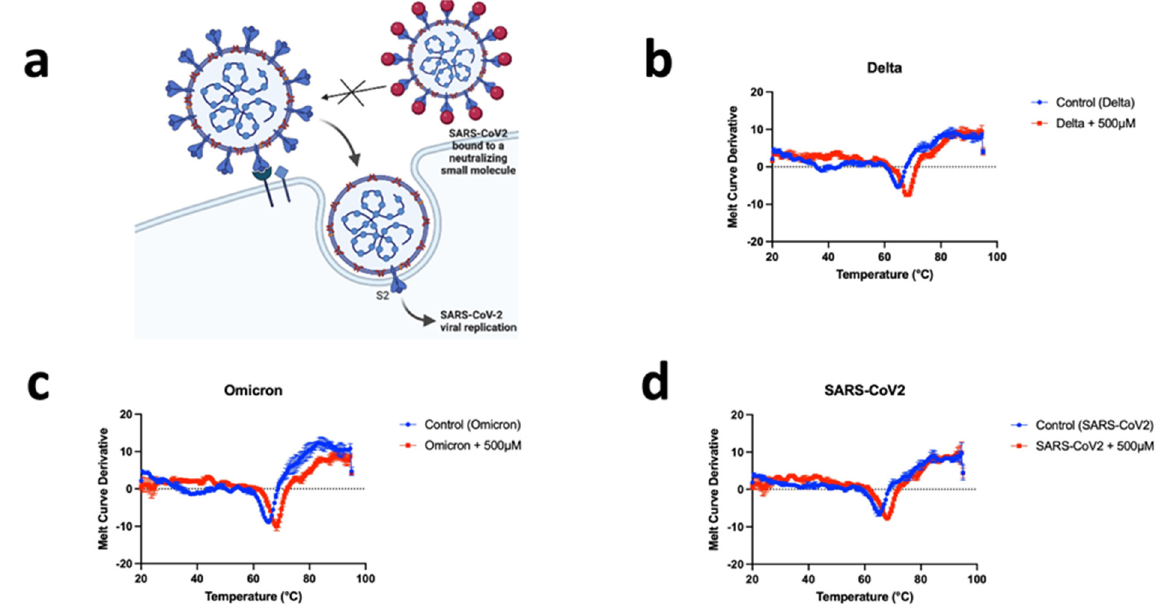
Figure 2. CD04872SC binds to the spike protein of SARS-CoV-2, Delta, and Omicron. ( a ) Schematic representation of the viral neutralization concept of SARS-CoV2 by a small molecule. Targeting a specific region of the spike proteins makes it possible to neutralize the coronavirus by disrupting the binding between its spike protein and receptor ACE2. ( b ) The thermal stability of the Delta variant pseudotyped lentiviral particles in the absence and presence of 500 μ M CD04872SC. ( c ) Thermal shift assay performed with Omicron variant pseudotyped viral particles in the absence and presence of 500 μ M CD04872SC. ( d ) Thermal stabilization of SARS-CoV2 pseudotyped viral particles in the presence of 500 μ M CD04872SC. The results are expressed as the mean of three experiments performed in triplicate; each triplicate was averaged before calculating the s.e.m. Lead compound CD04872SC is part of a “U.S. Provisional Patent Application No. 63/312,351, filed on Monday, 21 February 2022”.